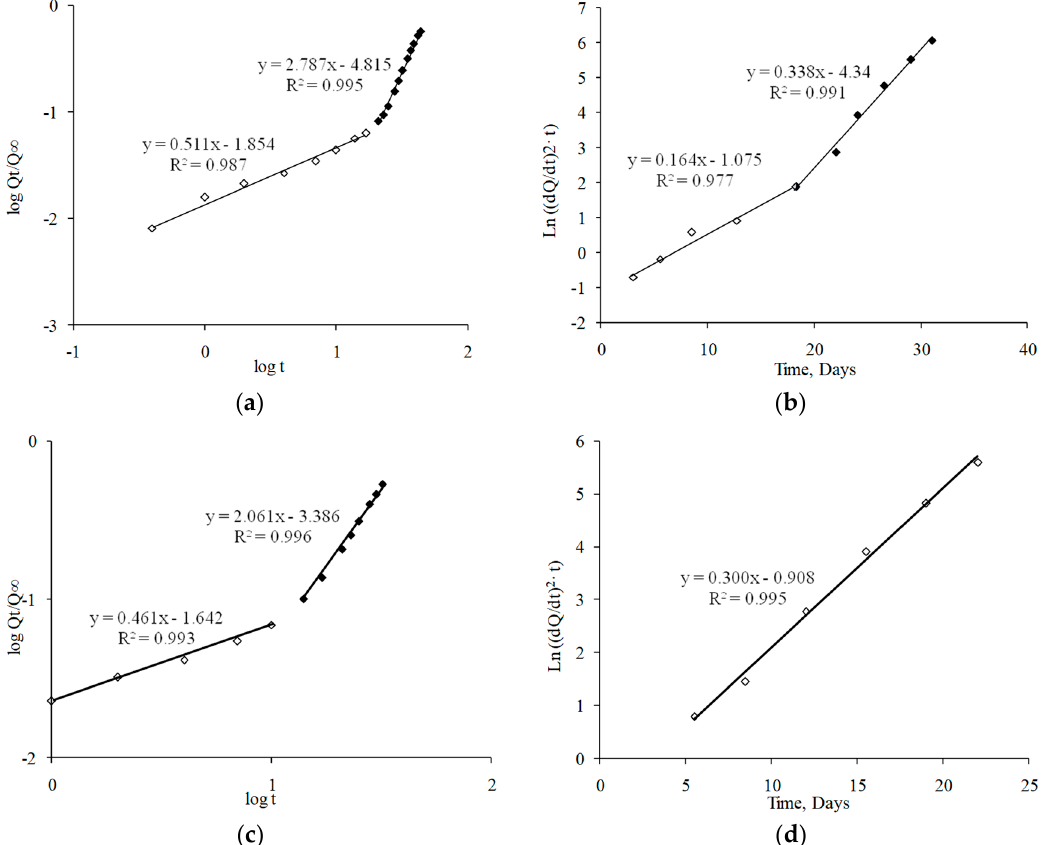
Figure 6. Kinetic fitting of dexamethasone release data: ( a ) Korsmeyer − Peppas model before sterilization; ( b ) Heller and Baker model before sterilization; ( c ) Korsmeyer − Peppas model after sterilization; ( d ) Heller and Baker model after sterilization. Table 4. Values of kinetic parameters of drug release profiles before and after sterilization. The value of “ n ” of Korsmeyer–Peppas model (95% confidence level, CL), “K c ” of Heller and Baker model, and coefficients of determination ( r 2 ).